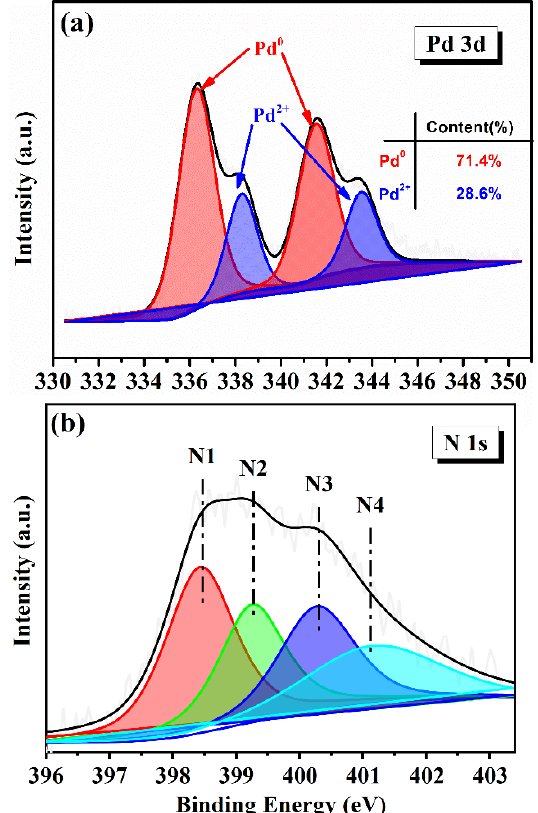
Figure 3. XPS spectra of Pd 3d ( a ) and N 1s ( b ) core level of Pd/NAC catalyst .